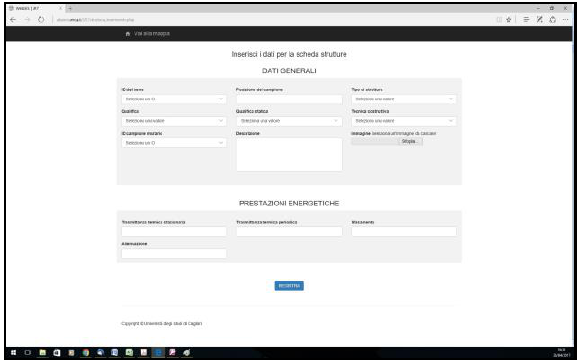
Figure 4. Structure input